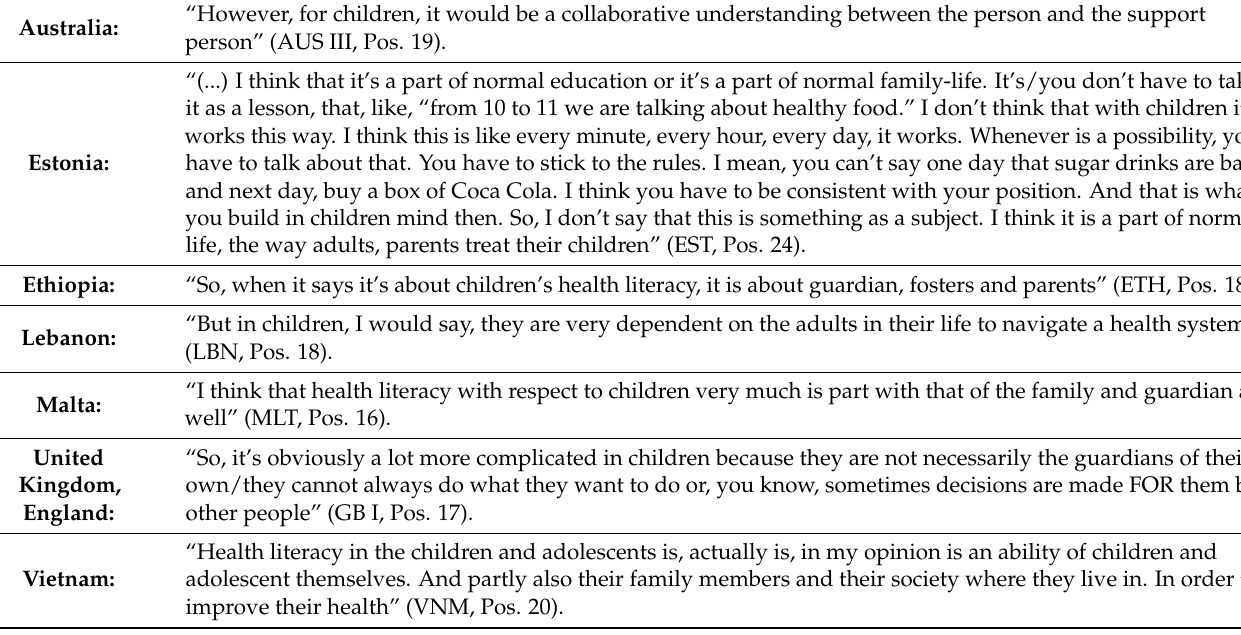
Table A4. Health literacy as the ability of